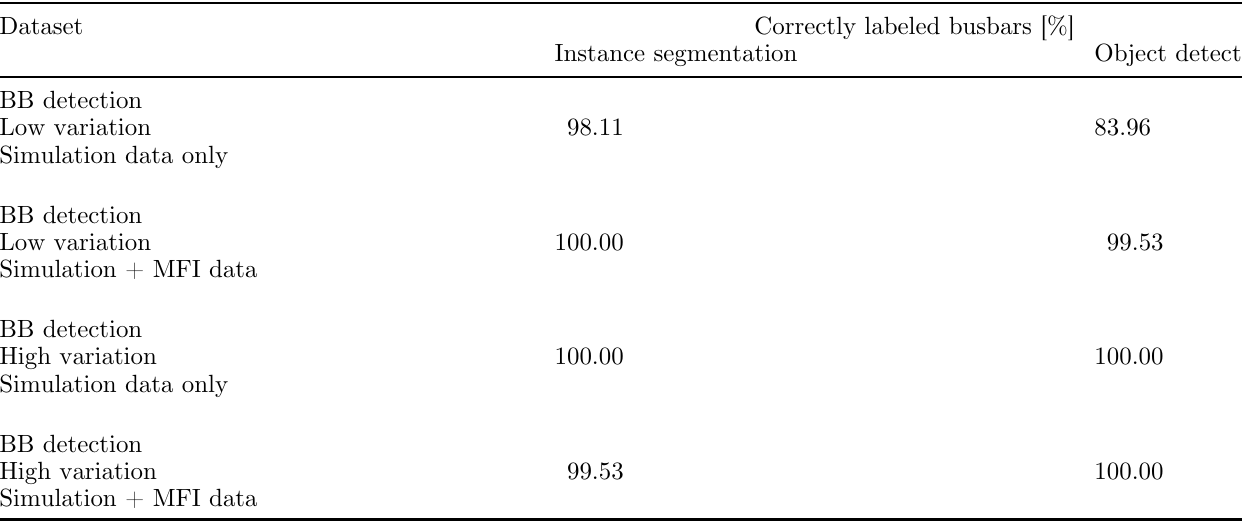
Table 5. Percentage of found